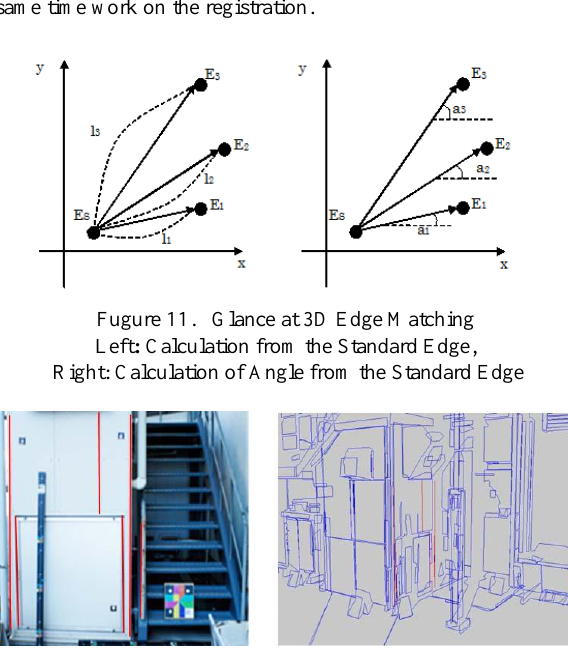
Figure 12. Left: The Edge detected from the rectified image. Right: The result of 3D Edge-Matching. The red line: the 3D edges of the Photogrammetry model. The blue: the 3D edges of the Point Cloud model The red line on Figure 12 Left is the vertical edges detected out length order for the registration and searched for the best